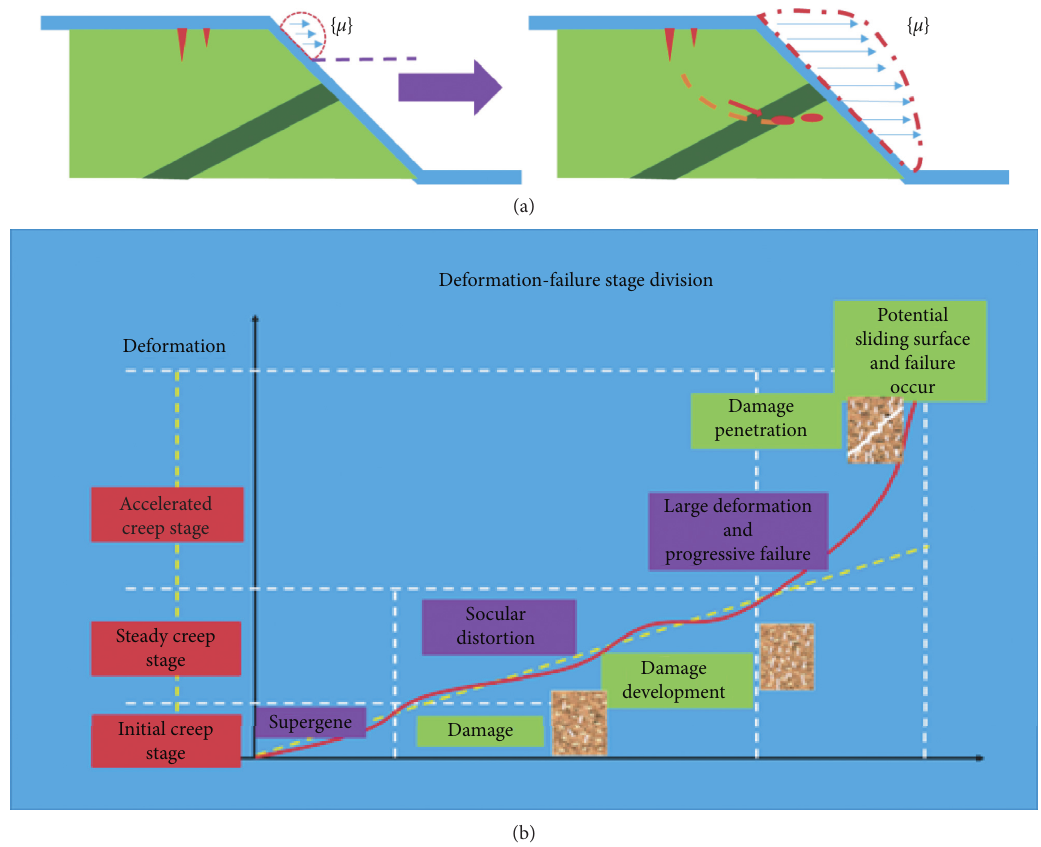
Figure 12: Deformation-failure evolution of